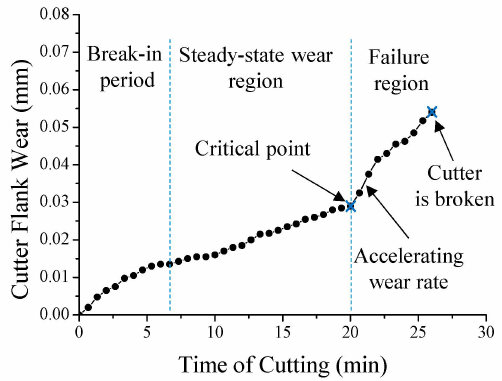
Figure 8. The tool wear curve (measuring the wear until the cutter is